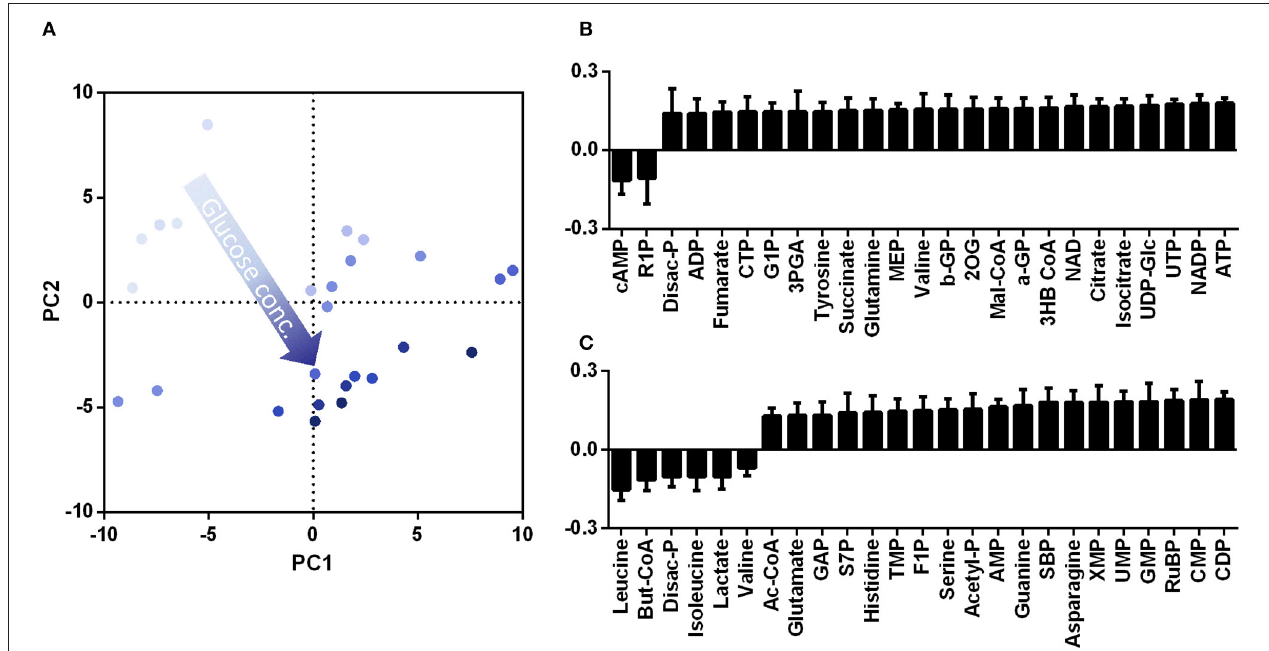
FIGURE 11 | Principal component analysis for substrate variations in B. subtilis WB PX43- pgs cultivations. The score plot (A) and loading data for PC1 (B) and PC2 (C) are given. The total substrate of 20g L − 1 was varied from 0 to 100% glucose (light blue to dark blue). The loading data for PC1 and PC2 is given for the metabolites with the highest impact on the principal